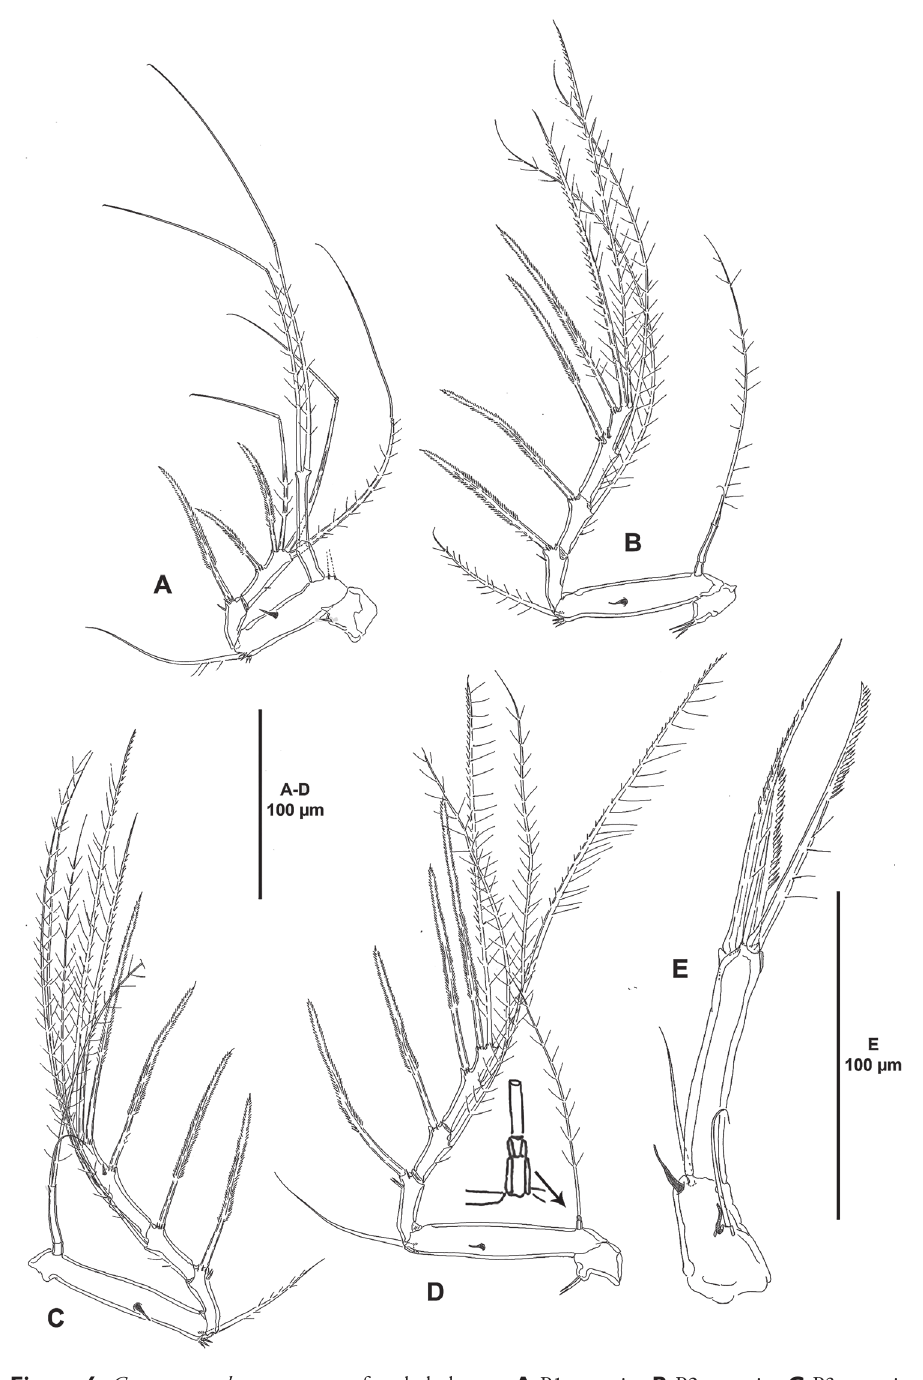
Figure 6. Ceratonotus elongatus sp. n., female holotype. A P1, anterior B P2, anterior C P3, anterior D P4, anterior, showing insert of endopod e P5,